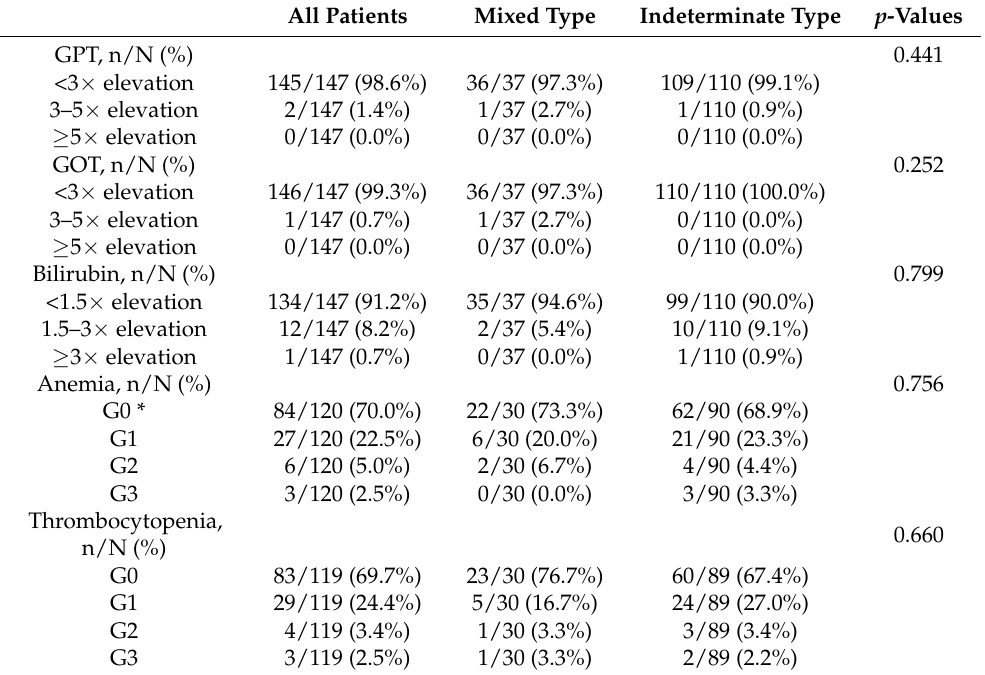
Table 4. Laboratory side effects during